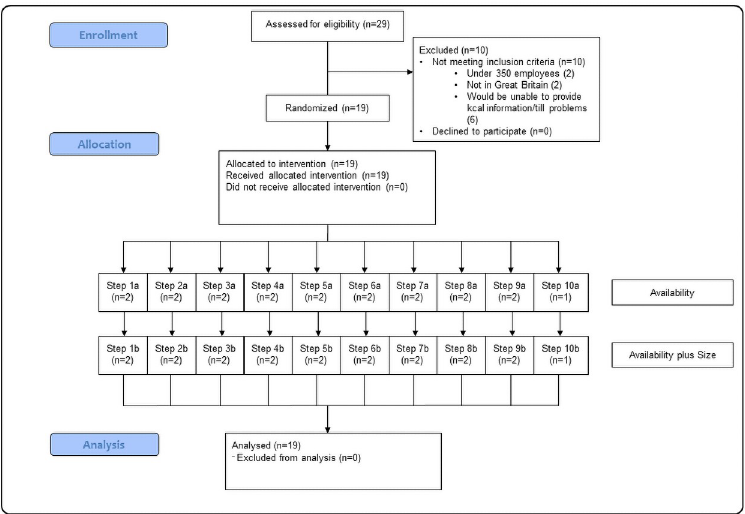
Fig 1. Study site flowchart. Note: n refers to cafeterias. Each step refers to weekly periods in which cafeterias start the interventions. See Fig 2 for the timings of these steps.